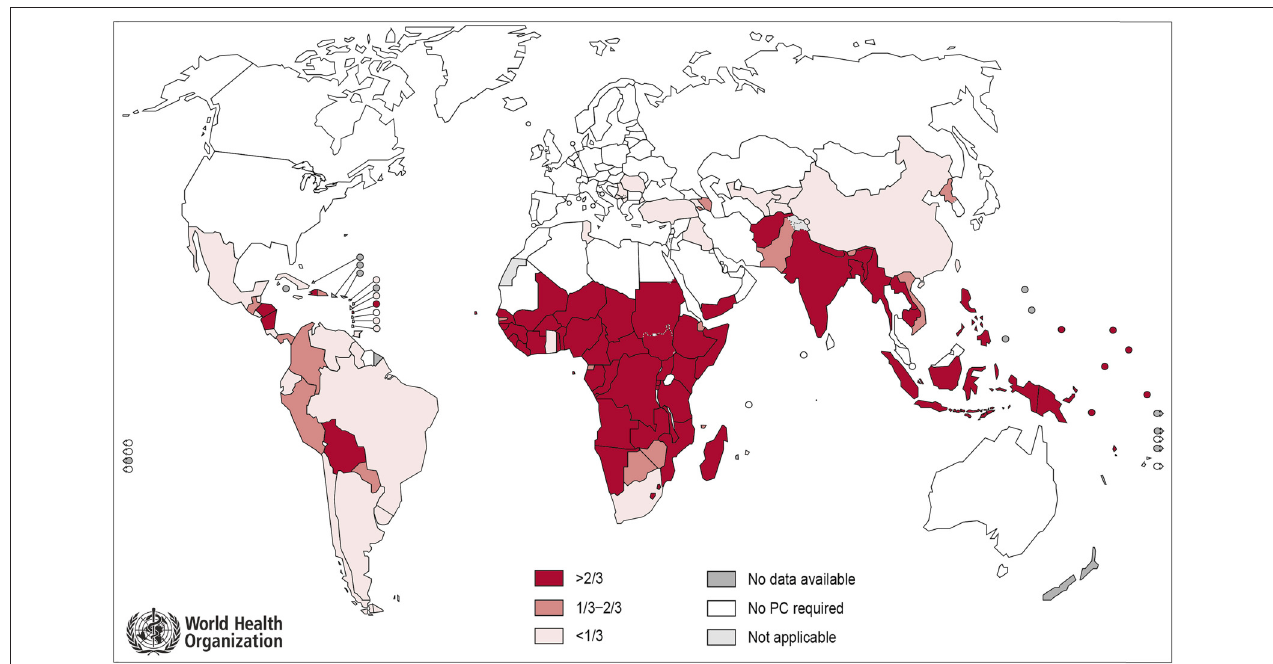
FIGURE 5 | Proportion of children (1–14 years of age) requiring preventive chemotherapy (PC) for soil-transmitted helminthiases, on a per-country basis in 2011. Adapted from World Health Organization, program on Control of Neglected Tropical Diseases (http://gamapserver.who.int/mapLibrary/Files/Maps/